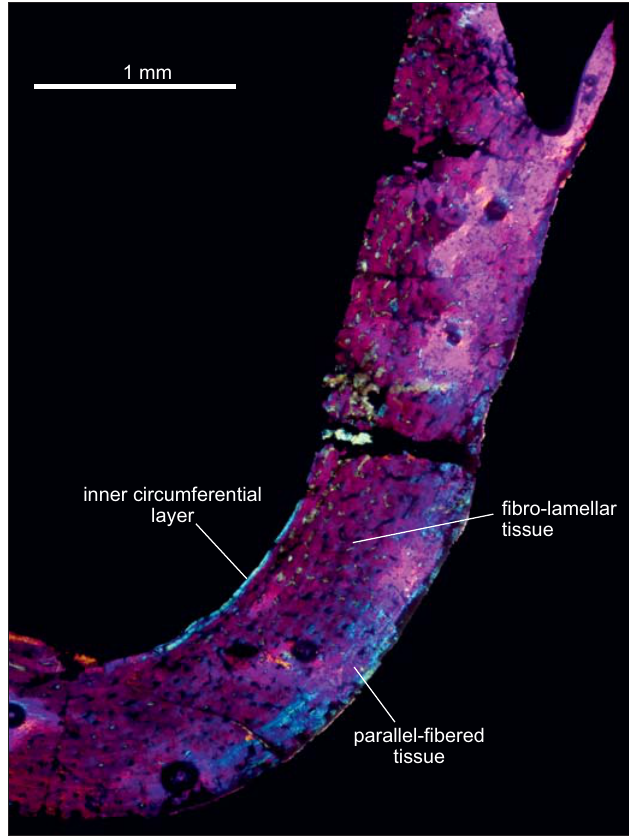
Fig. 6. Femur of archosauromorph Tropidosuchus romeri Arcucci, 1990 (PVL-4604, in lambda light) from La Rioja province, NW Argentina; Chaña- res Formation, Carnian (Late Triassic). Section showing the main features of the femur bone microstructure.